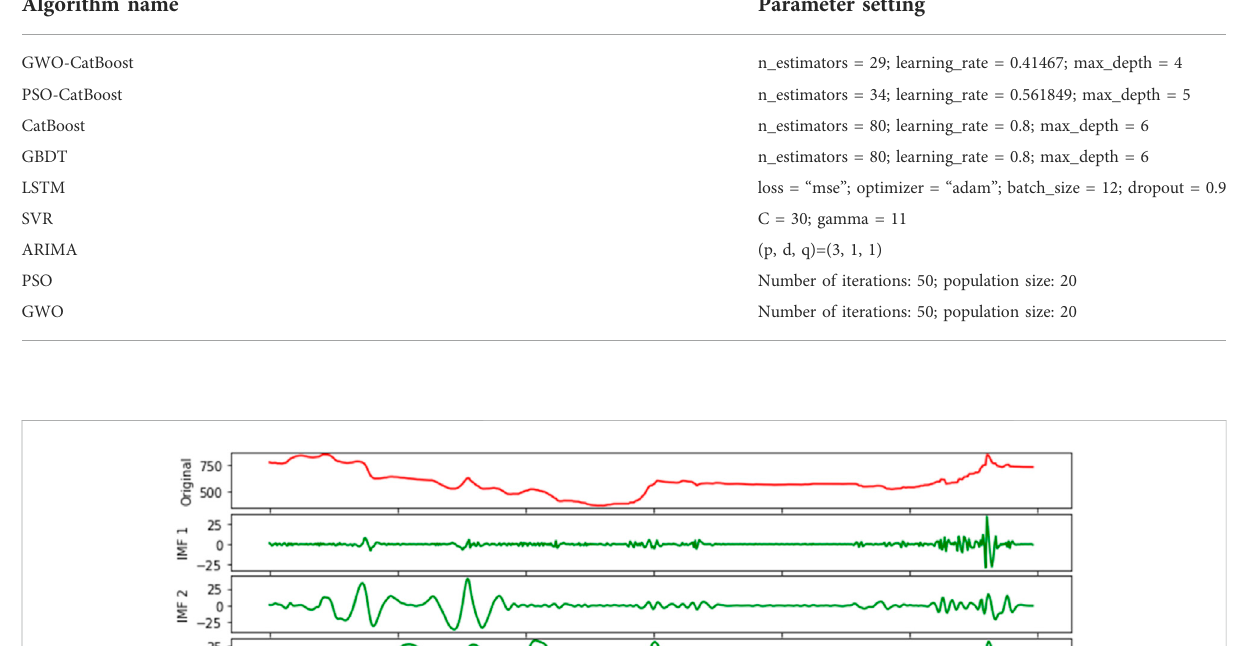
TABLE 4 Algorithm parameter setting.